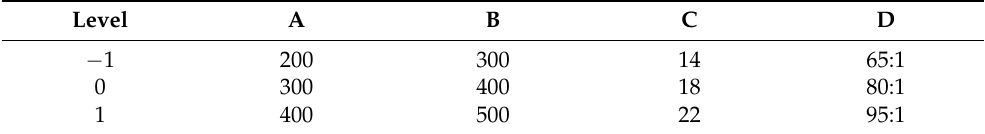
Table 1. Design of factors levels for RSM. (A is the microwave power/(W), B is the ultrasonic power/(W), C is the extraction time/(min), and D is the liquid-to-material ratio/(g/mL)). Level A B C D − 1 200 300 14 65:1 0 300 400 18 80:1 1 400 500 22